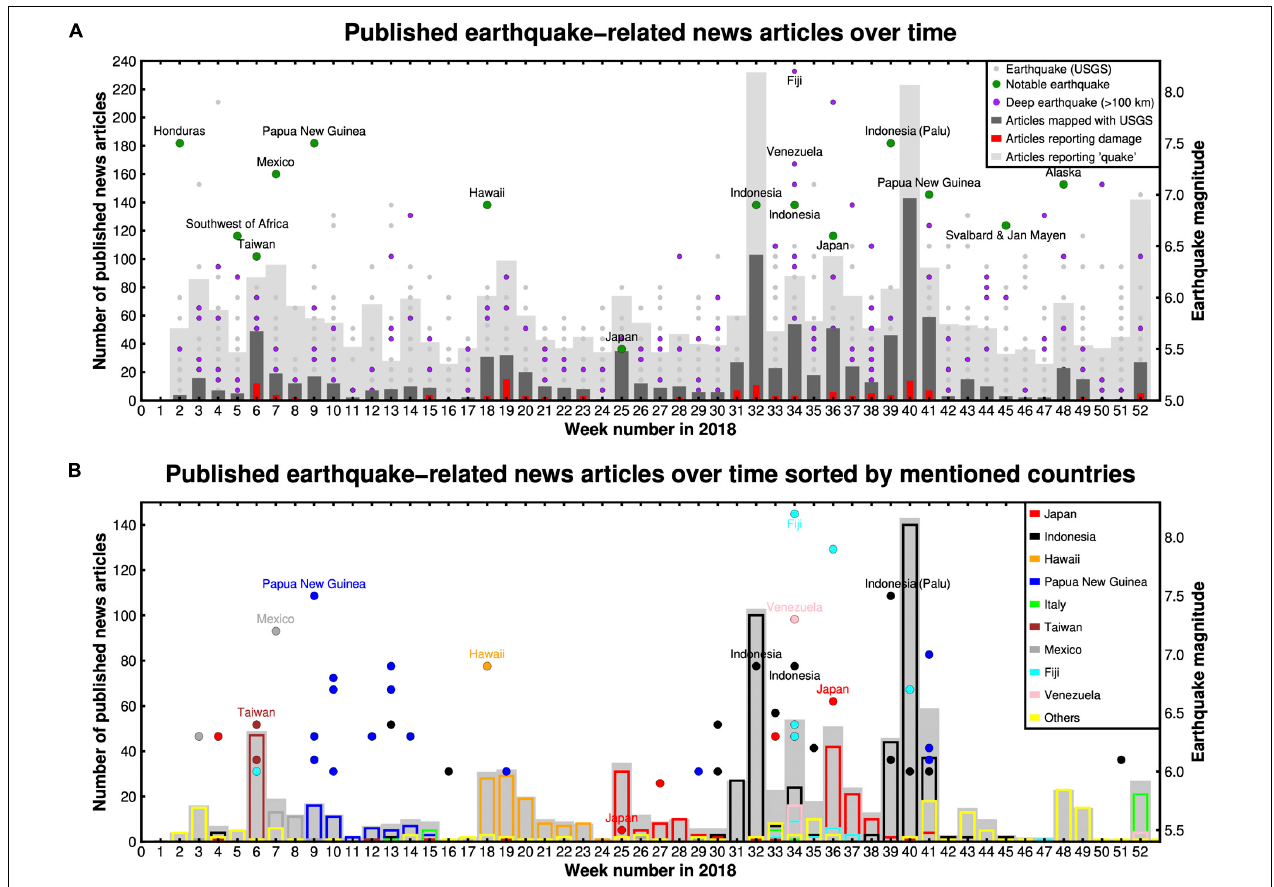
FIGURE 3 | Weekly bins of detected earthquake-related news articles during 2018. (A) Light gray bars represent the number of articles which had the word “quake” in the text (3,355). Dark gray bars represent the number of articles which were mapped with an earthquake event (1,042). Red bars represent the number of articles which reported earthquake damage. Green dots are notable earthquakes corresponding to peaks in the bins or discussed in the text. Purple dots are deep earthquakes ( > 100 km) with strong magnitudes. Gray dots are other earthquakes listed in the USGS catalog that occurred during the year. (B) Same as top graph but sorted by color-coded countries referred to in the articles. Dots are earthquakes color-coded by country and have a magnitude ≥ 6 (except for Japan weeks 25–30 with lower magnitude M ≥ 5.5). Note that the y -axes have been expanded for better viewing, and that some events may happen at the end of a week resulting in articles flowing onto the next week